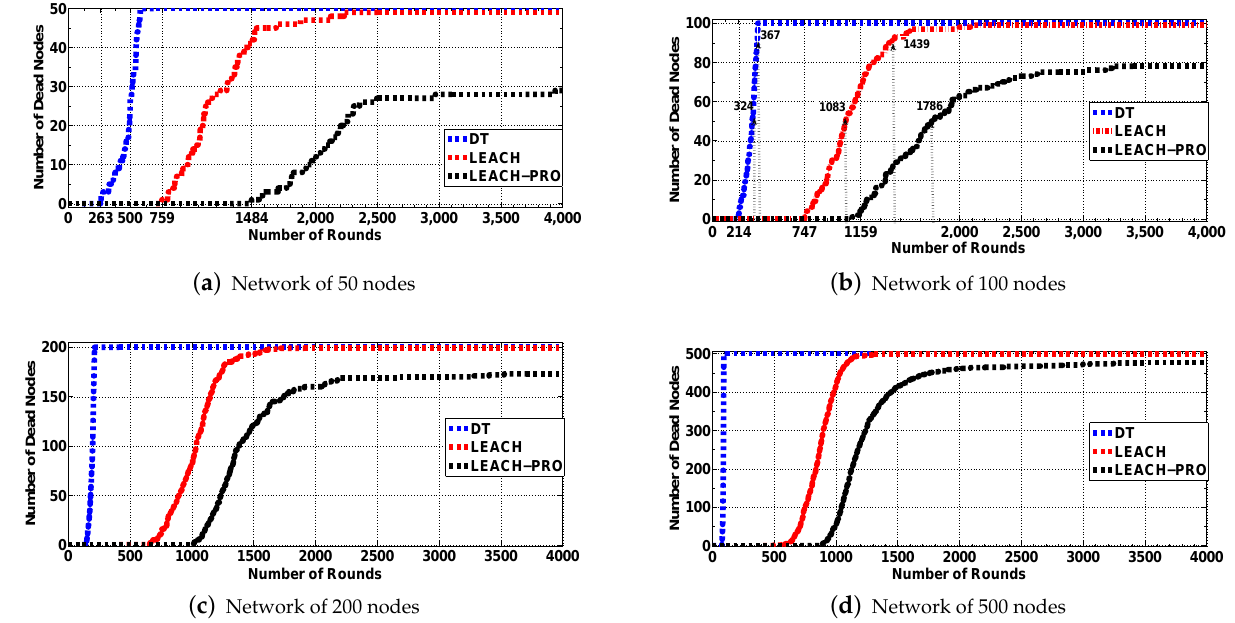
( d ) Network of 500 nodes